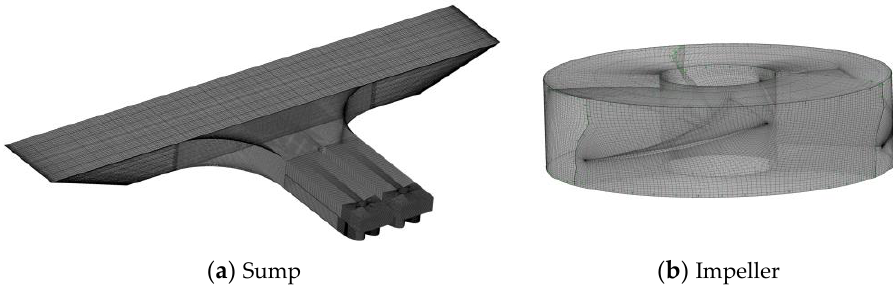
Figure 2. Grid division.